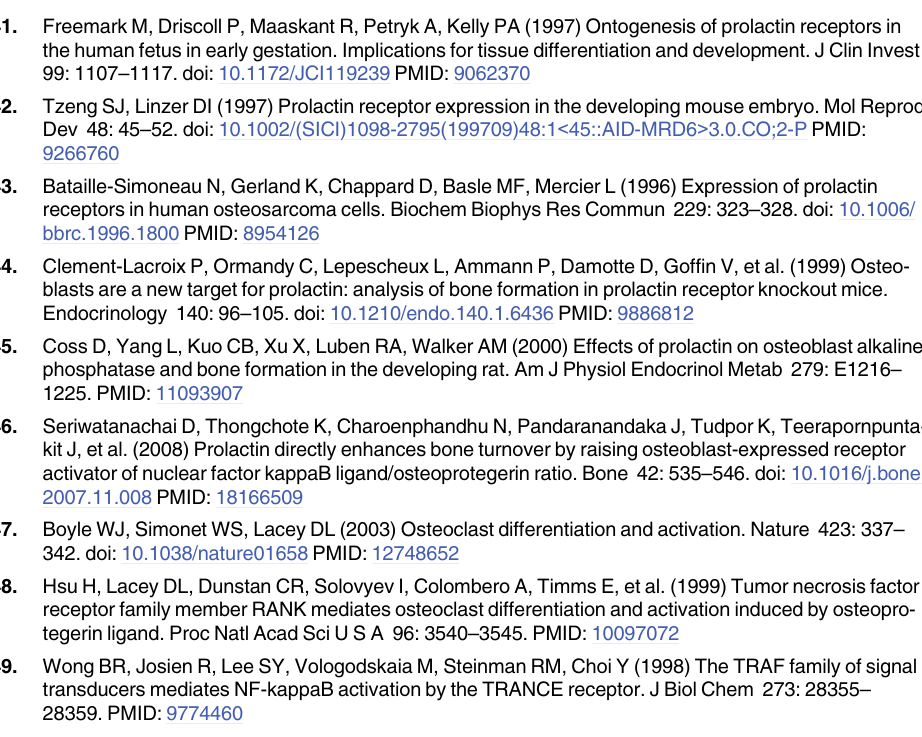
PLOS ONE | DOI:10.1371/journal.pone.0171011 February 2,